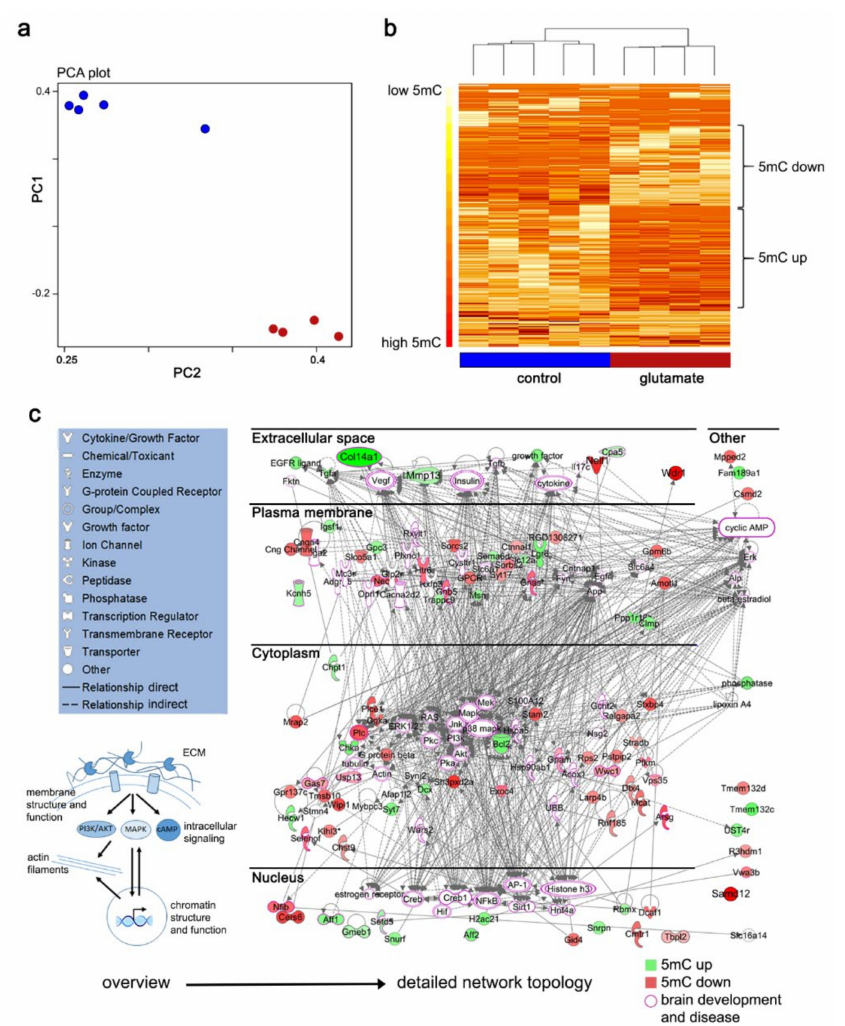
Figure 4. ( a , b ) PCA plot and heatmap showing distinct DNA methylation patterns in control (blue) and epileptogenic networks (red). Clustered heatmap of methylation percentages (ranging from 0% to 100 %) of all differentially methylated positions with an F-value of 0.05 or lower. Colors are relative, with darker colors representing higher methylation percentages. ( c ) Functional relationships between differentially methylated genes and their encoded proteins (5mC up = green, 5mC down red), whereby the spatial location of nodes was shifted into their corresponding subcellular